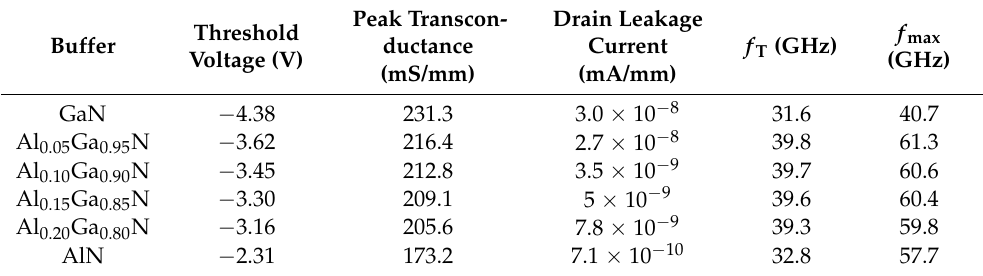
Table 1. DC and AC simulation results of the HEMT with different buffer layers.